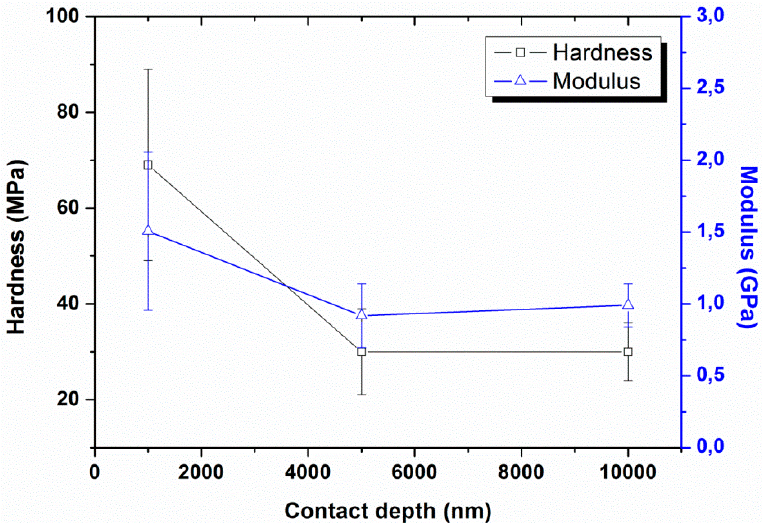
Figure 8. Hardness and modulus as a function of contact depth at a vibration amplitude of 2 nm and strain rate of 0.05 s − 1 . The solid lines are just a guide for the eye. Bars represent standard deviations.